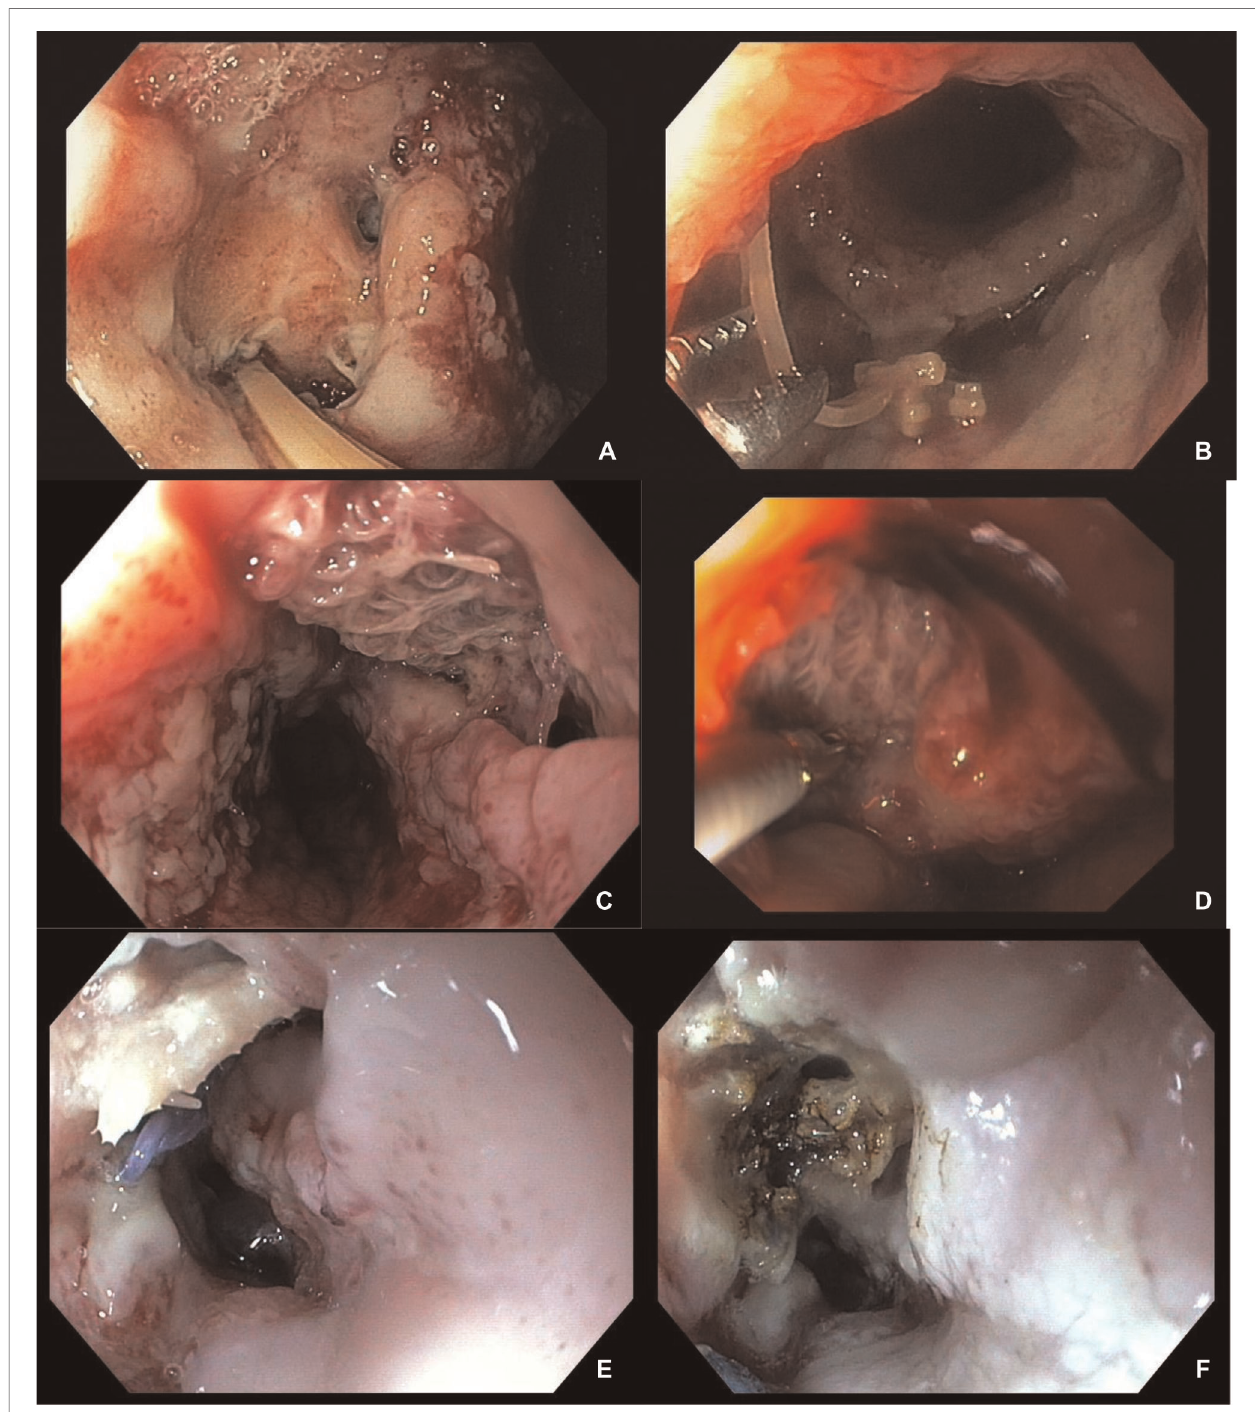
FIGURE 4 | ( A – F) exemplary presentation of foreign material at the anastomotic leak site. Leak of the oesophagogastrostomy after minimally invasive Ivor Lewis surgery. Detectable vessel clip on the azygos vein ( A ). Removal of vessel clips using forceps ( B ). Leakage of the esophagus after revisional hiatal surgery with mesh augmented hiatoplasty ( C , E ). Partial repositioning ( D ) and status after thermal destruction of the intraluminal mesh portion by argon plasma coagulation ( F